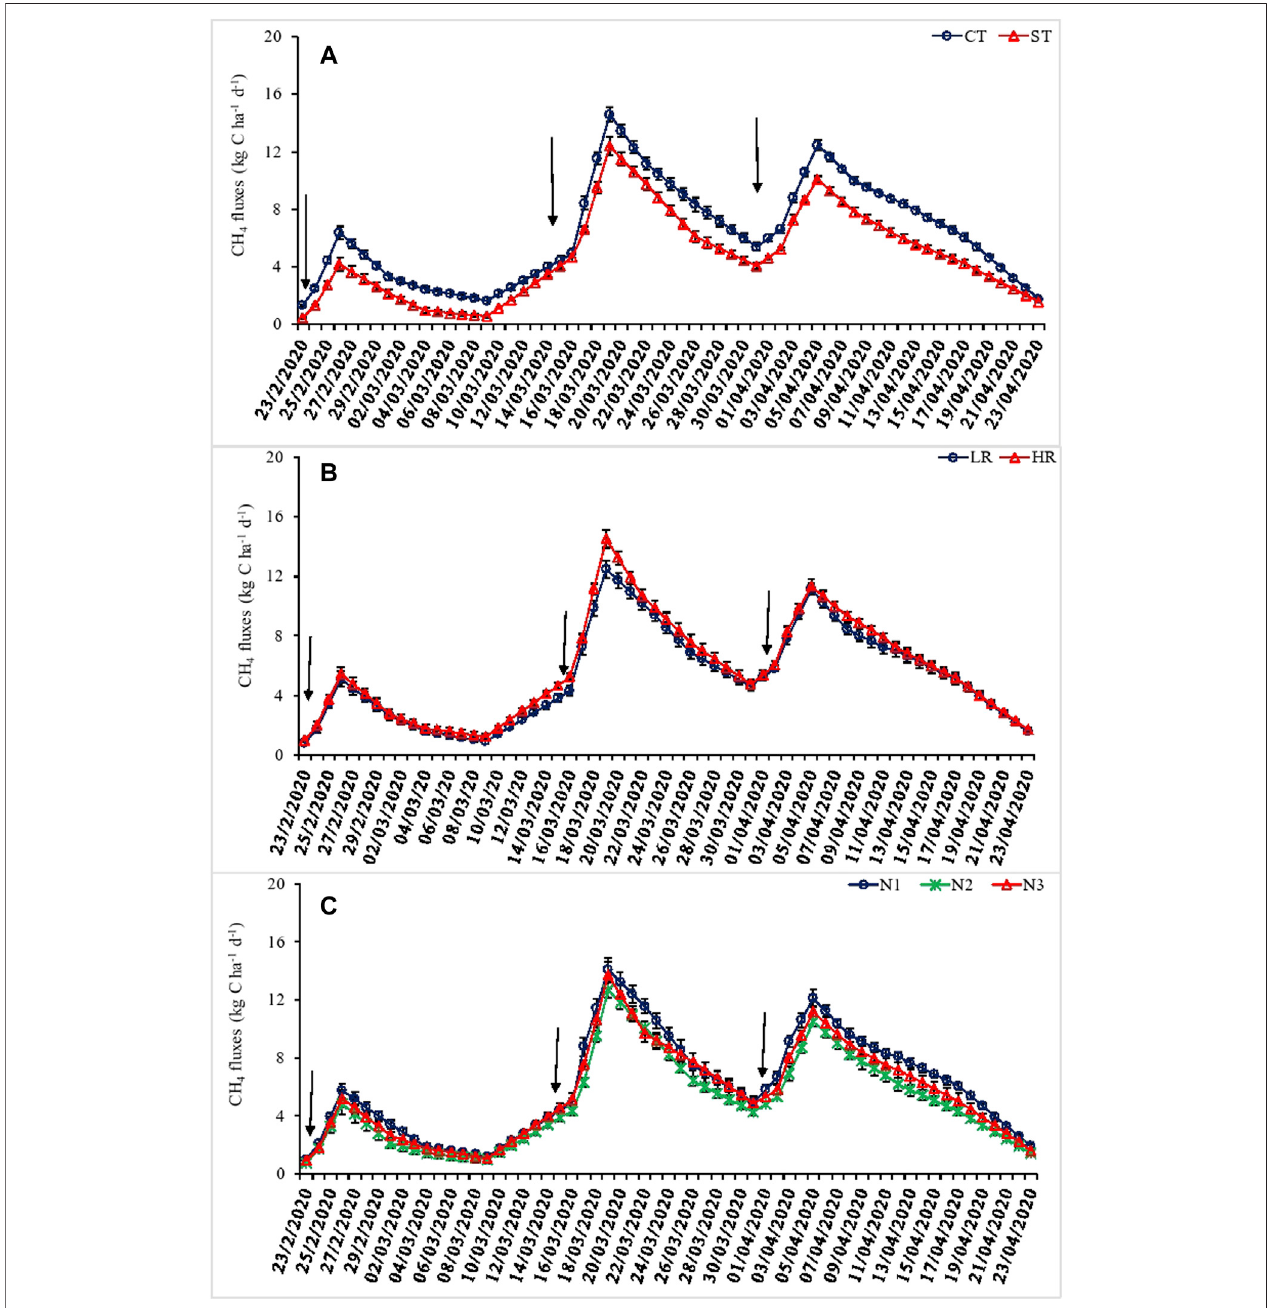
FIGURE 2 | CH 4 emissions (mean ± SE; n = 3) in (A) two tillage systems, (B) two residue levels, and (C) three N application rates over time, days after urea application, in conventional (CT) and strip (ST) tillage systems across the residue levels and N rates in Boro rice; arrow shows the day of urea application.